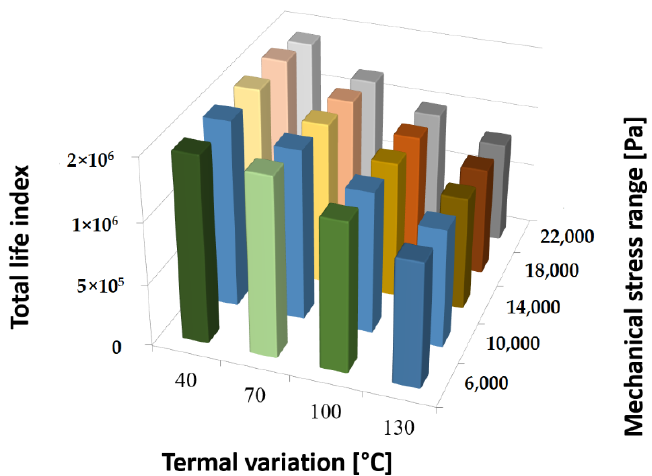
Figure 18. Thermal variation and stress range vs. total life index in PV panels.